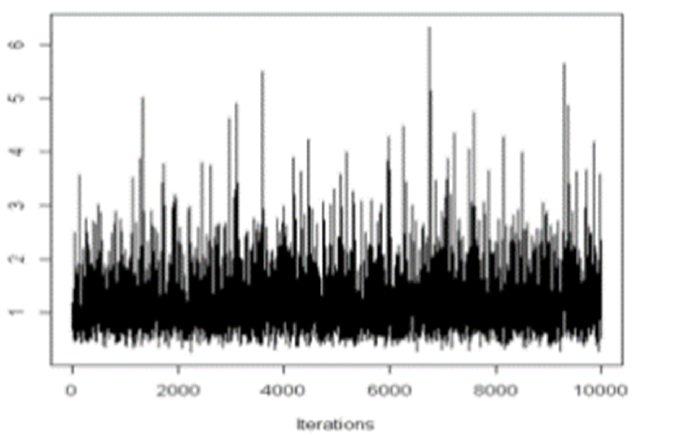
2 for the HBLD Figure 4. Trace plot of  (cid:2870) for the HBLD model. Figure 4. Trace plot of τ Figure 4. Trace plot of  (cid:2870) for the HBLD model.